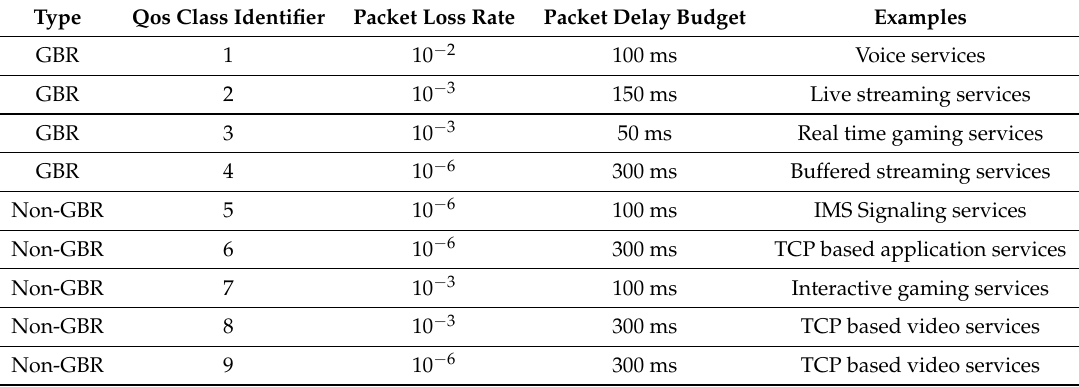
Table 2. Standardized QoS class identifier (QCI) characteristics in LTE/LTE-A [6,30,31]. Type Qos Class Identifier Packet Loss Rate Packet Delay Budget